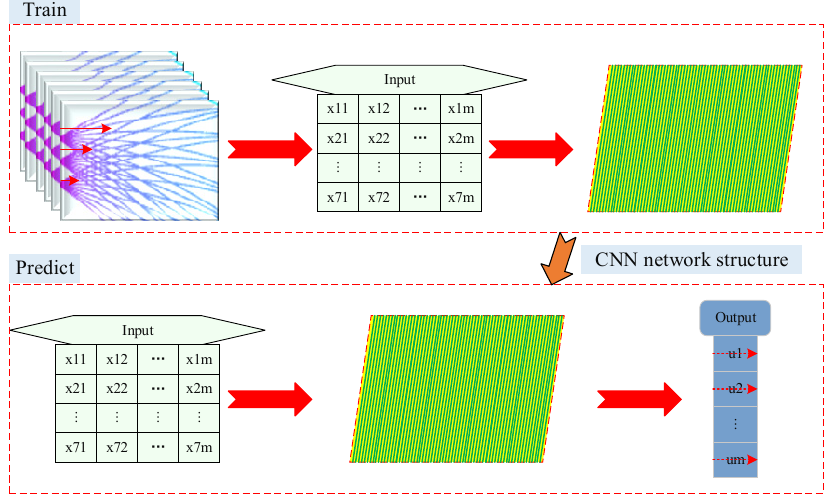
Figure 9. Convolutional neural network training flow chart.